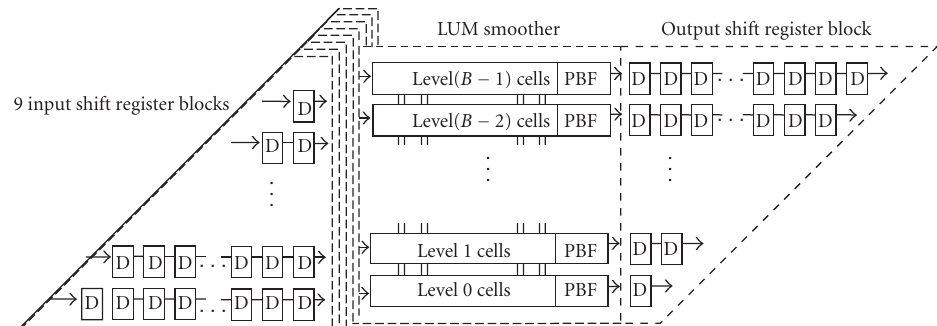
Figure 7: Pipelined scheme with input and output shift registers.